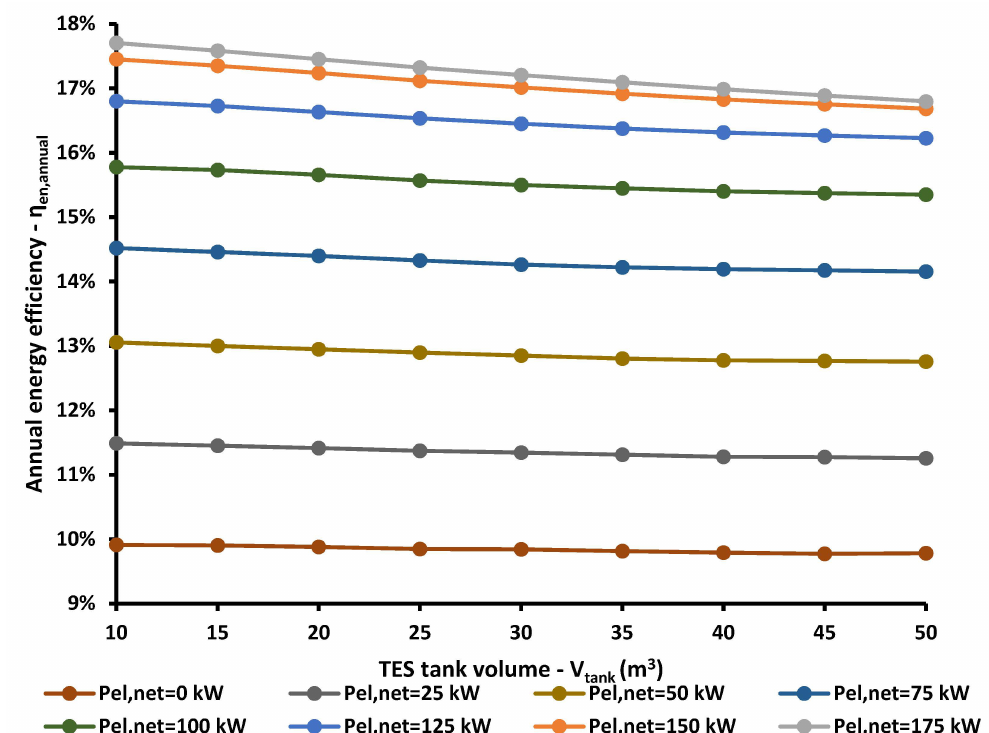
Figure 7. Annual energy efficiency for different values of net electricity load and TES tank volume.